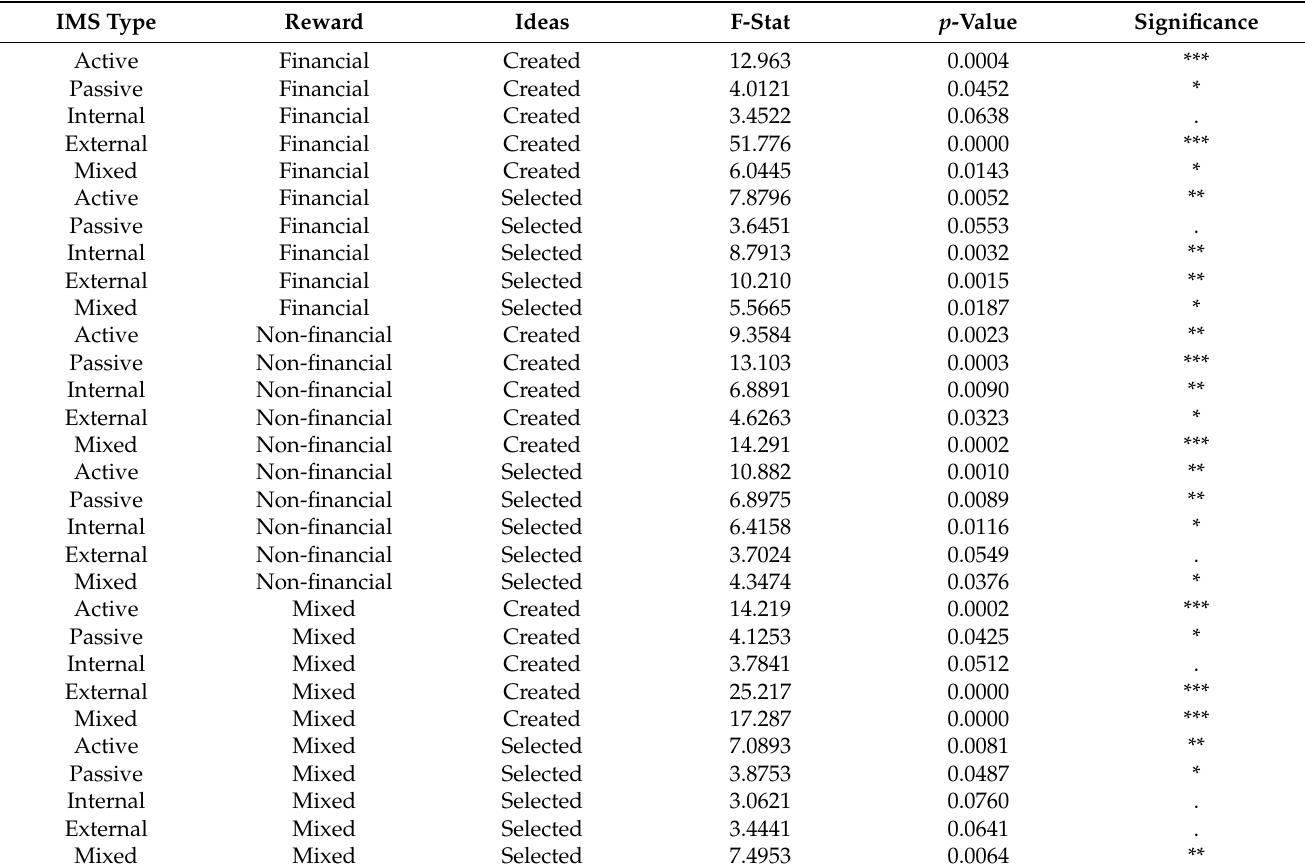
Table 4. Granger causality test statistics by IMS and reward